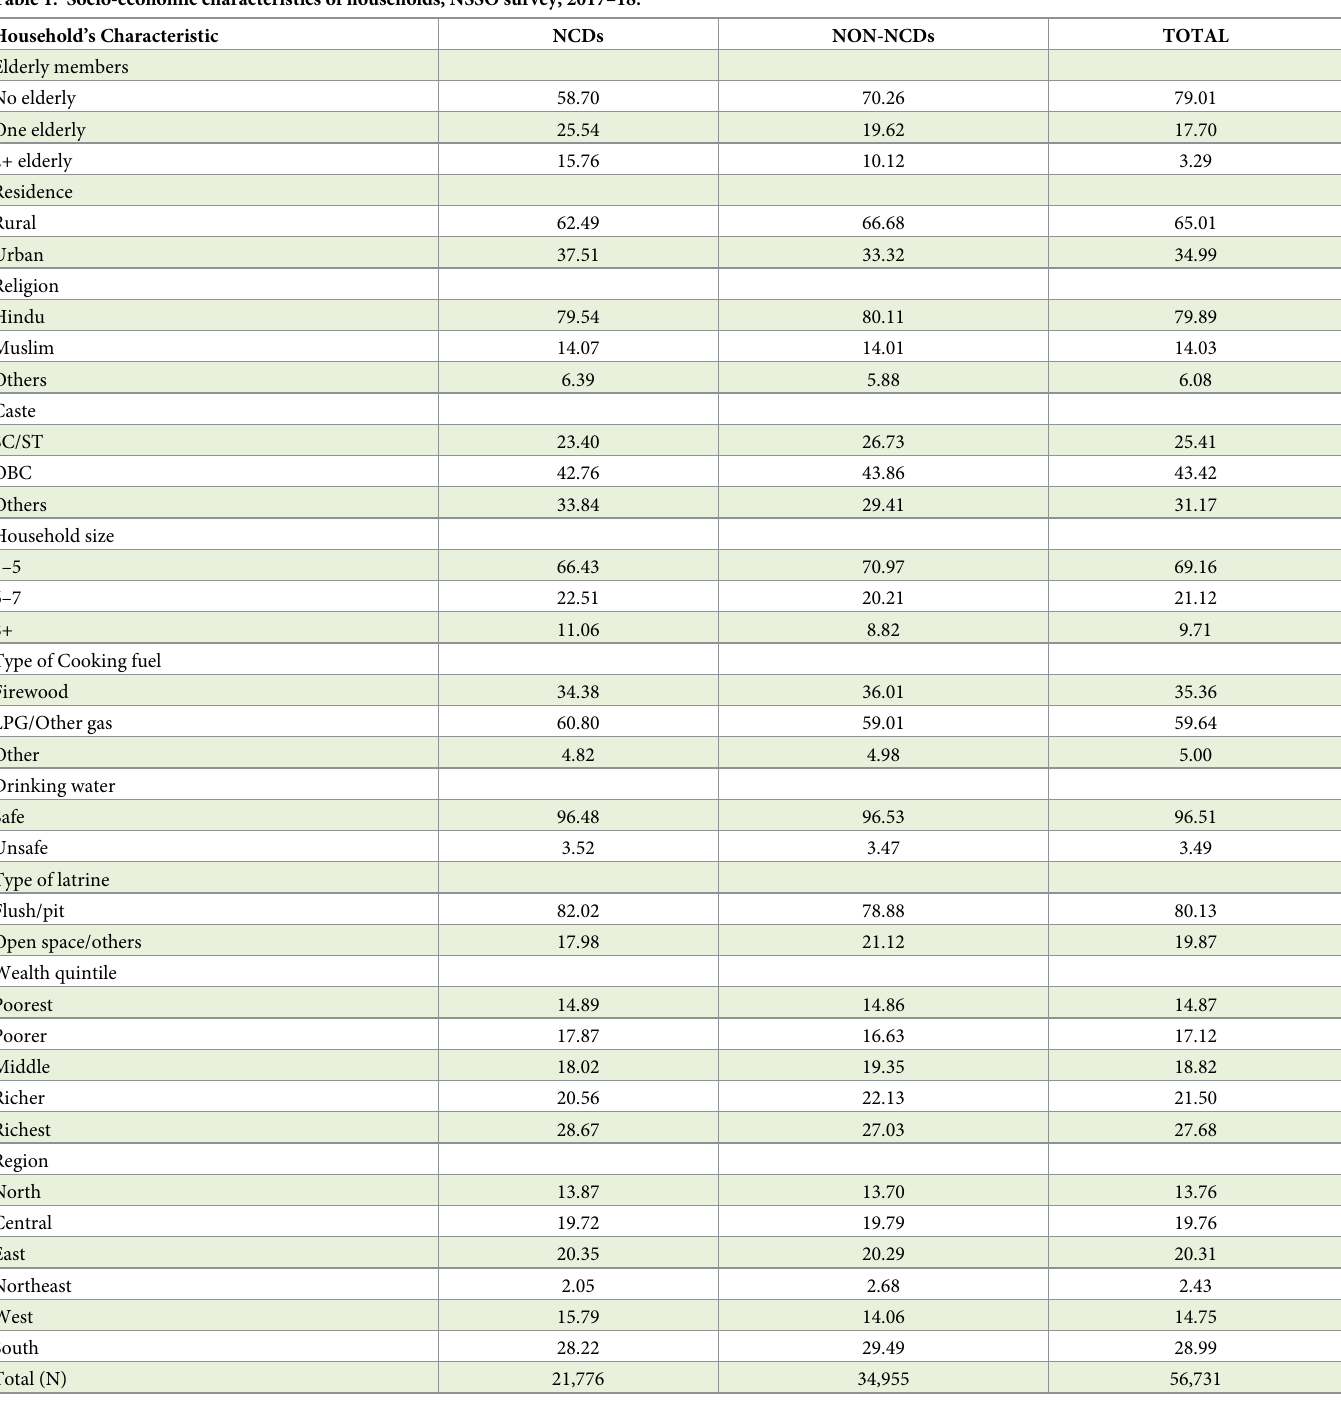
Table 1. Socio-economic characteristics of households, NSSO survey,